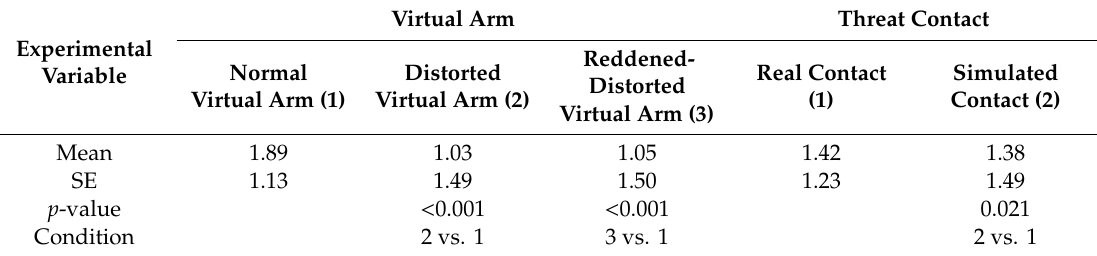
Table 2. Scoring values in terms of mean, standard error (SE) and p -values for all the di ff erent experimental